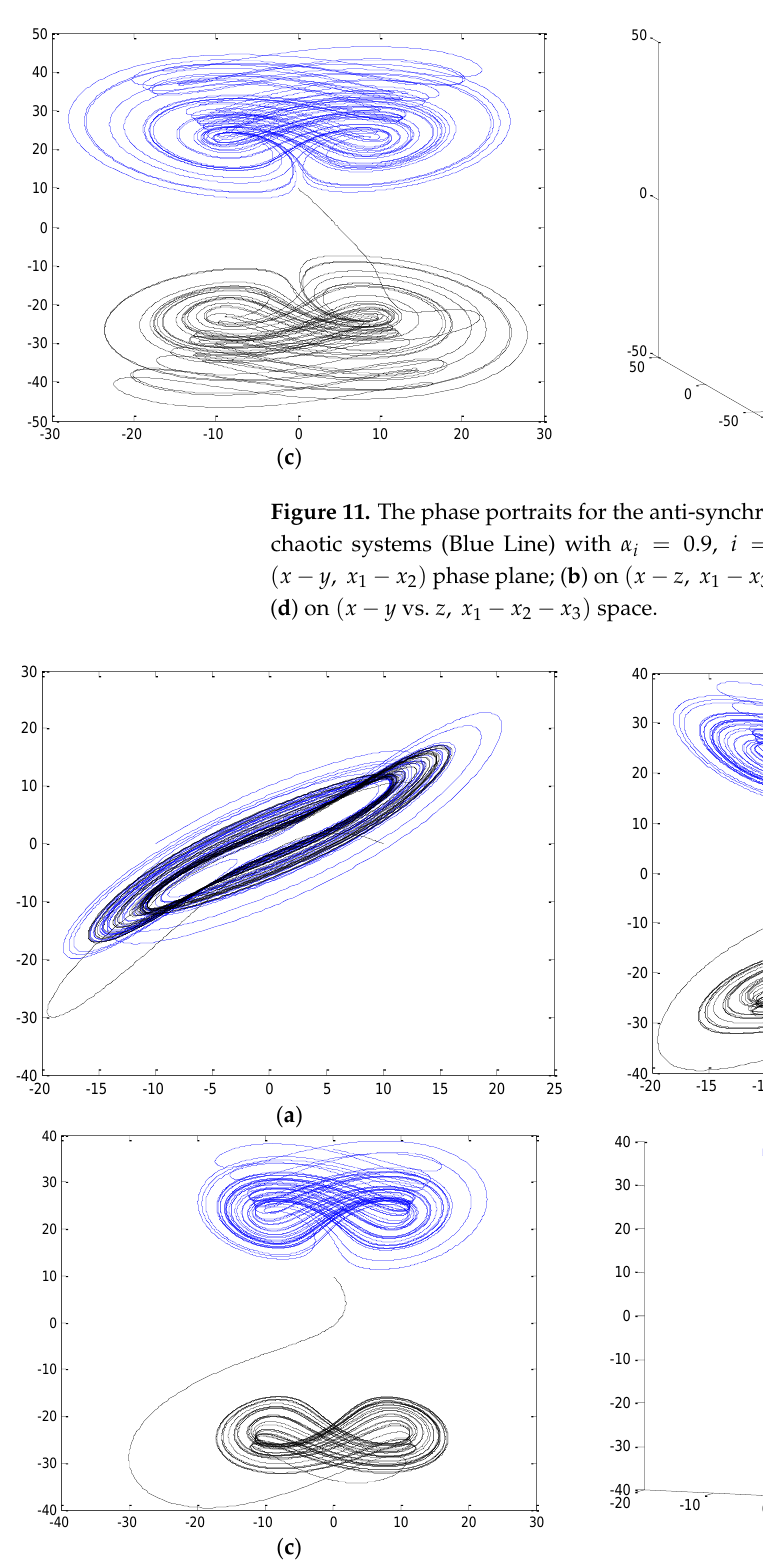
Figure 12. Fractional order derivative with 𝛼 = 0.9,0.8,and 0.5 and time delay 𝜏 = 5 s. The phase portraits for the time-delay anti-synchronization between Chen (Black Line) and Lorenz chaotic systems (Blue Line): ( a ) On (𝑥 − 𝑦,𝑥 1 − 𝑥 2 ) phase plane; ( b ) on (𝑥 − 𝑧,𝑥 1 − 𝑥 3 ) phase plane; ( c ) on (𝑦 − 𝑧,𝑥 2 − 𝑥 3 ) phase plane; ( d ) on (𝑥 − 𝑦 − 𝑧,𝑥 1 − 𝑥 2 − 𝑥 3 ) space.